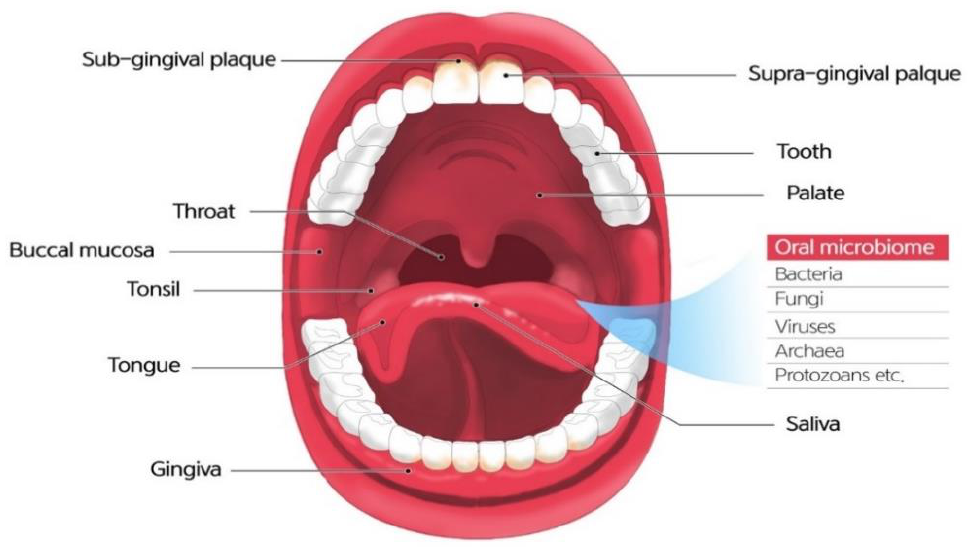
Figure 1. Oral cavity and the composition of oral microbiome.